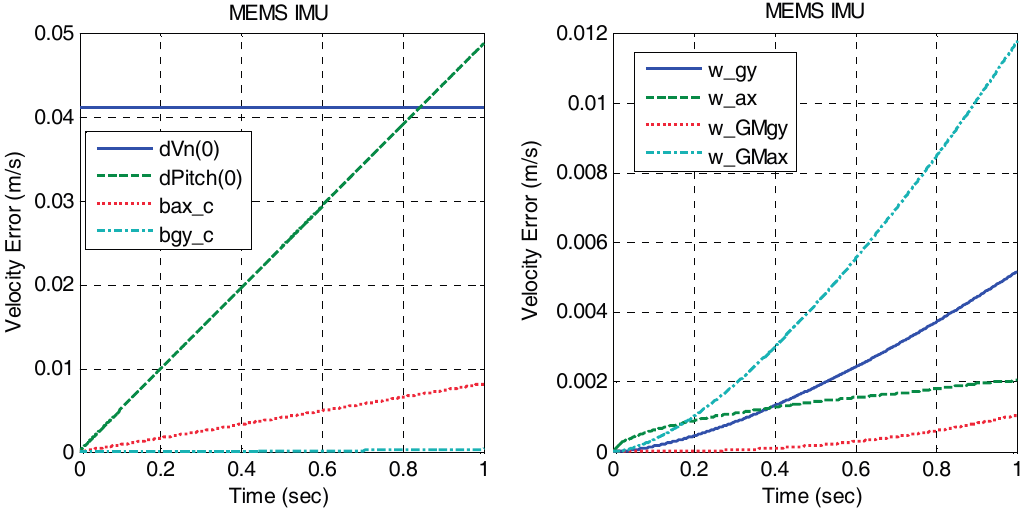
Figure 3. The quantitative velocity errors caused by micro-electro-mechanical system (MEMS) INS error sources.